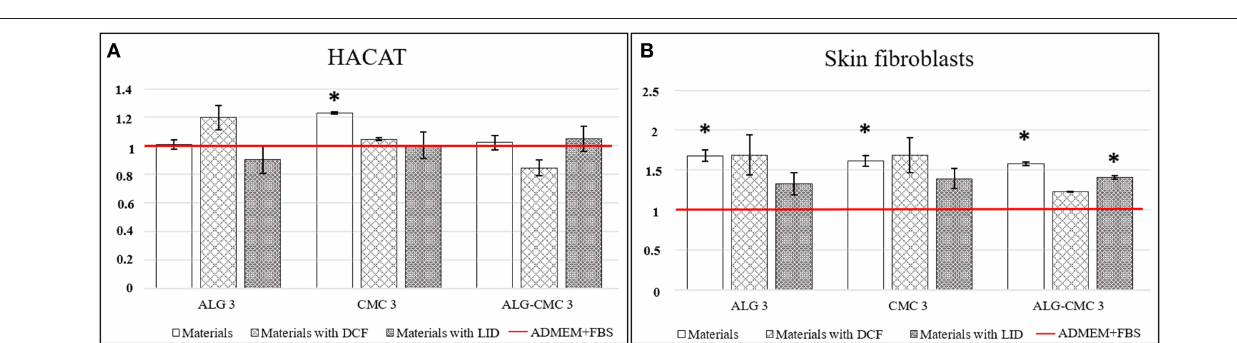
FIGURE 6 | Drug release data of DCF and LID loaded polymers fitted to various kinetic models.